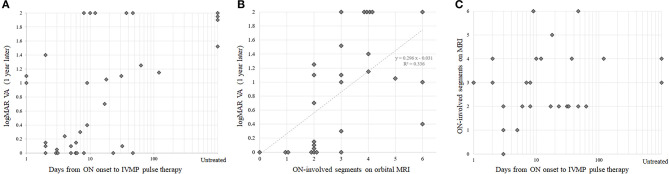
Correlations between treatment rapidity, optic neuritis (ON) severity, and visual prognosis. Scatter plots with visual prognosis and therapeutic rapidity (A), with visual prognosis and ON severity (B), and with ON severity and therapeutic rapidity (C). Note that the horizontal axes in panels (A,C) are log transformed. IVMP, intravenous methylprednisolone; logMAR, logarithmic minimum angle of resolution; ON, optic neuritis; VA, visual acuity.